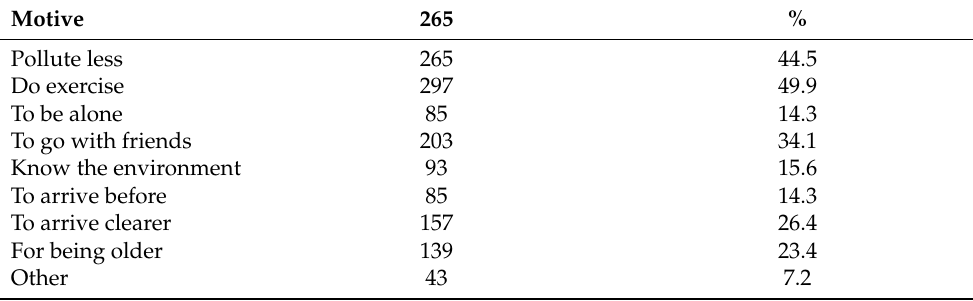
Table 11. Reasons to walk to school. Percentages refer to the number of students who walked to school on the day of the survey